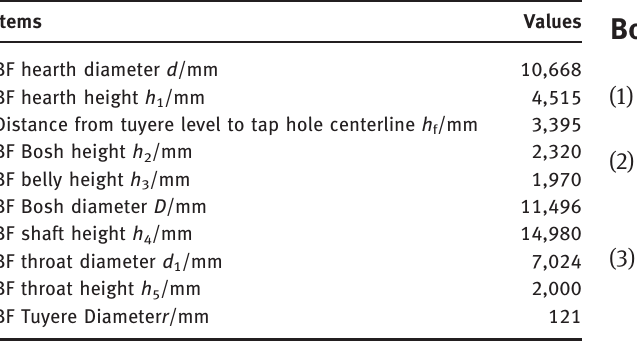
Table 2: Structure parameters of the model. Items Values BF hearth diameter d /mm  , 